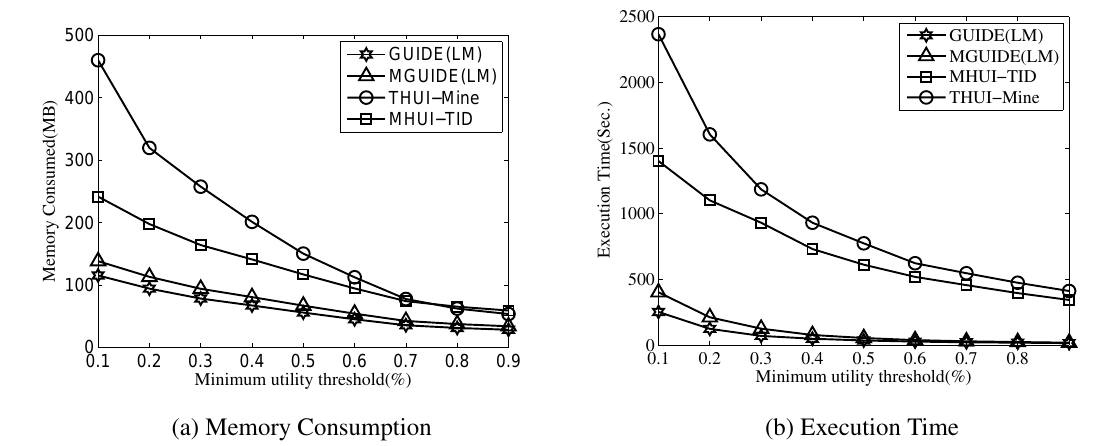
Fig. 8: Performance on Retail